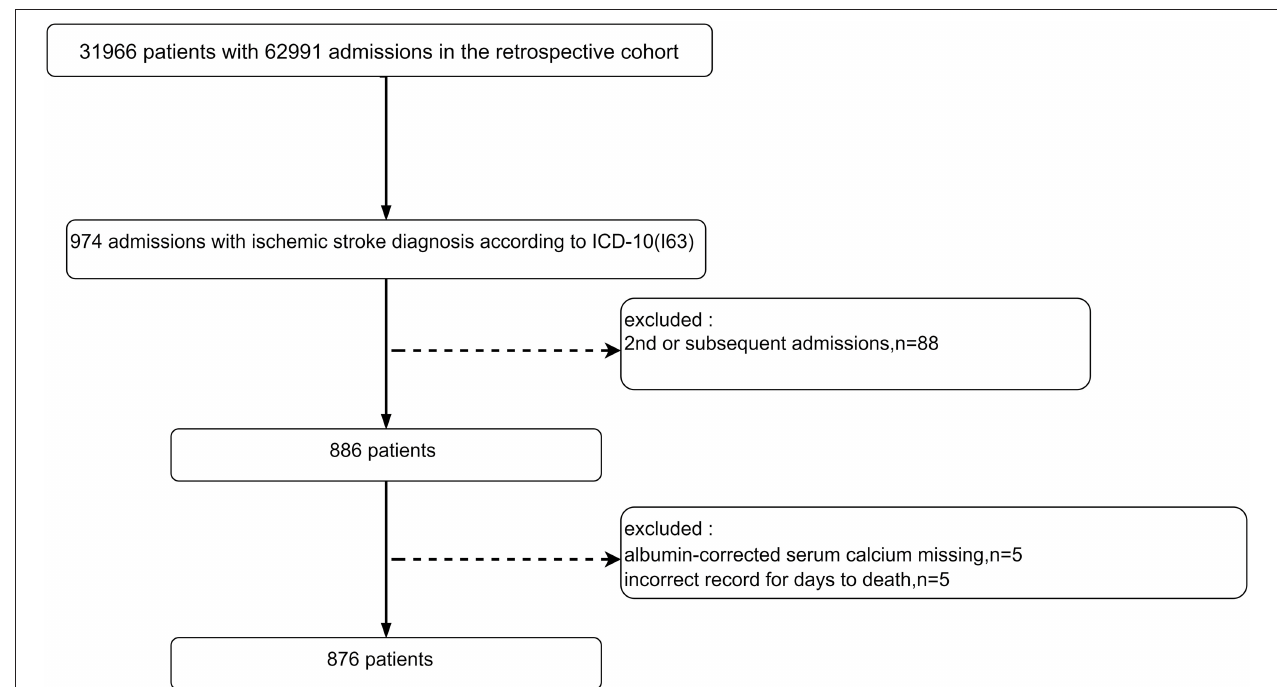
FIGURE 1 | Flowchart of screening the study population.